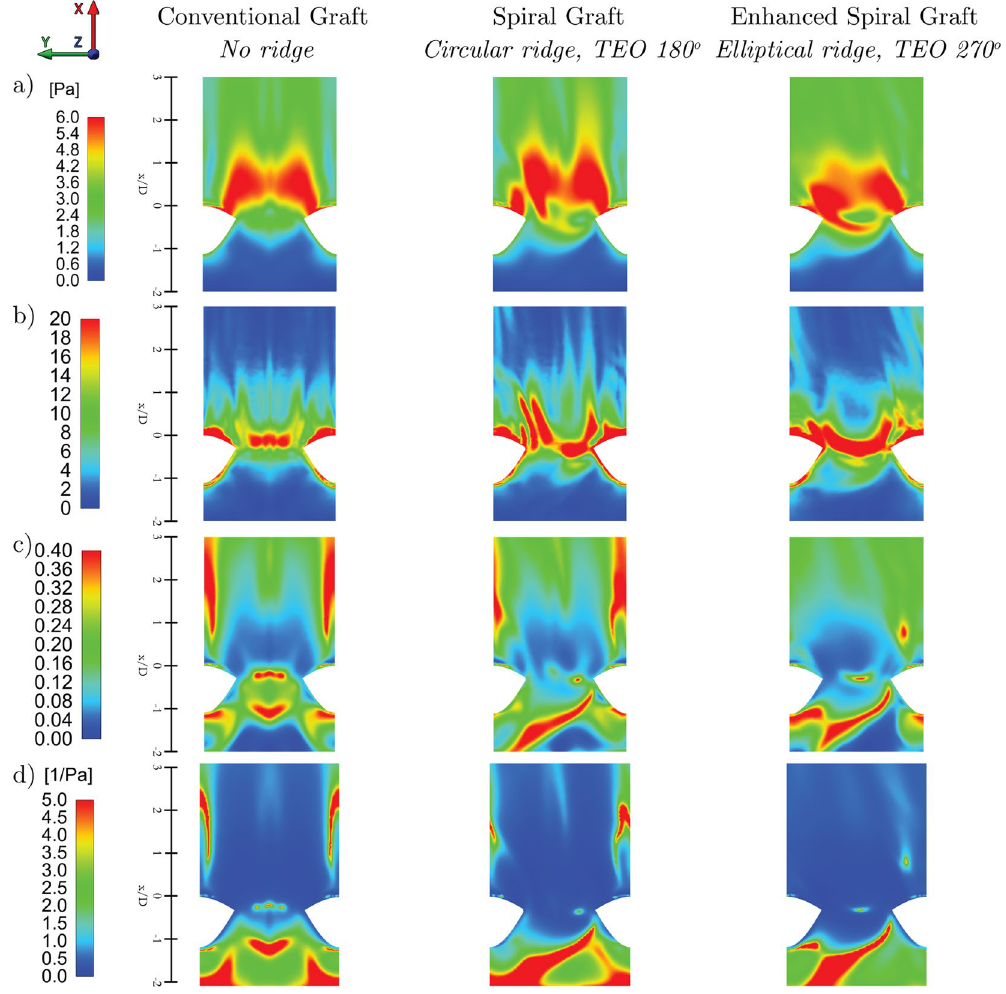
Figure 7. Distributions of ( a ) TAWSS, ( b ) TAWSSG, ( c ) OSI and ( d ) RRT onto the developed surface of the host artery for different designs of